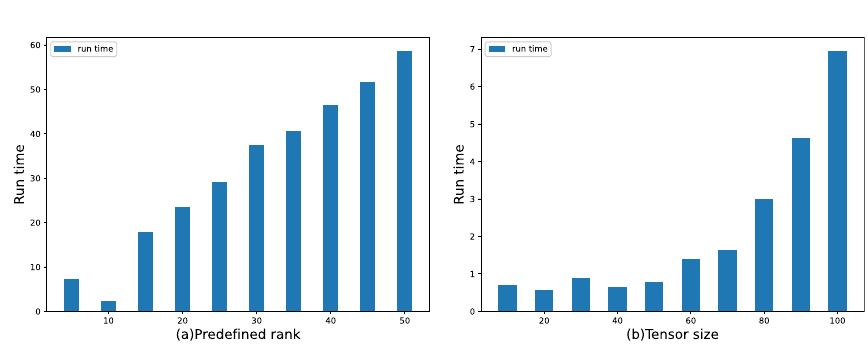
Fig. 9 CPU run time with different predefined ranks and tensor